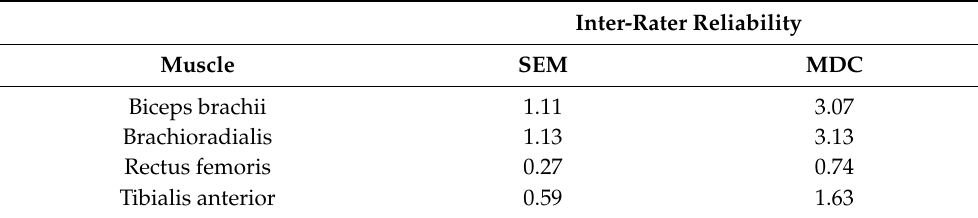
Table 5. Results of the Absolute Reliability Index for myotonometer’s muscle tone in inter-rater